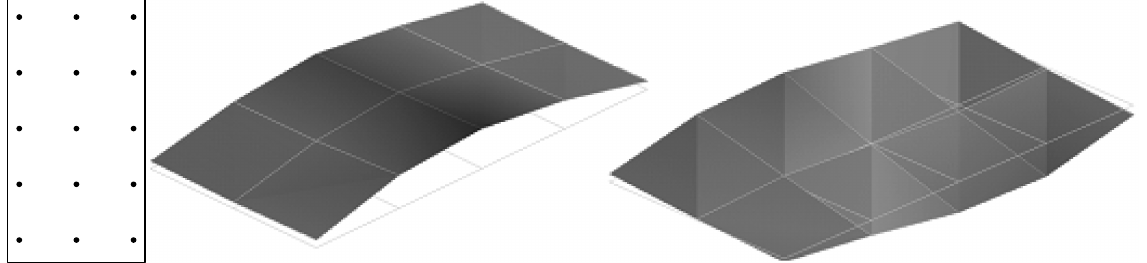
Fig. 11. The first and the second mode shapes of the plate (Left – measurement points; Right – mode